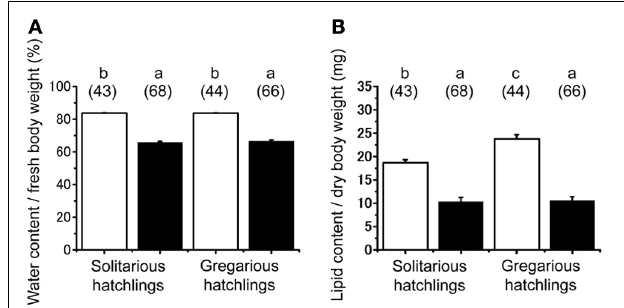
FIGURE 8 | Starvation-induced physiological changes associated in hatchlings produced by solitarious (isolated-reared mother) and gregarious hatchlings (crowd-reared females) in Schistocerca gregaria . (A) Water content / fresh body weight (mg); (B) lipid content/dry body weight (mg). Each variable was measured before (open bar) and after starvation (closed bar). Numbers in parentheses indicate sample sizes. Different letters above each bar indicate significant differences at P < 0 . 05 by Steel-Dwass test. Vertical lines indicate SE .